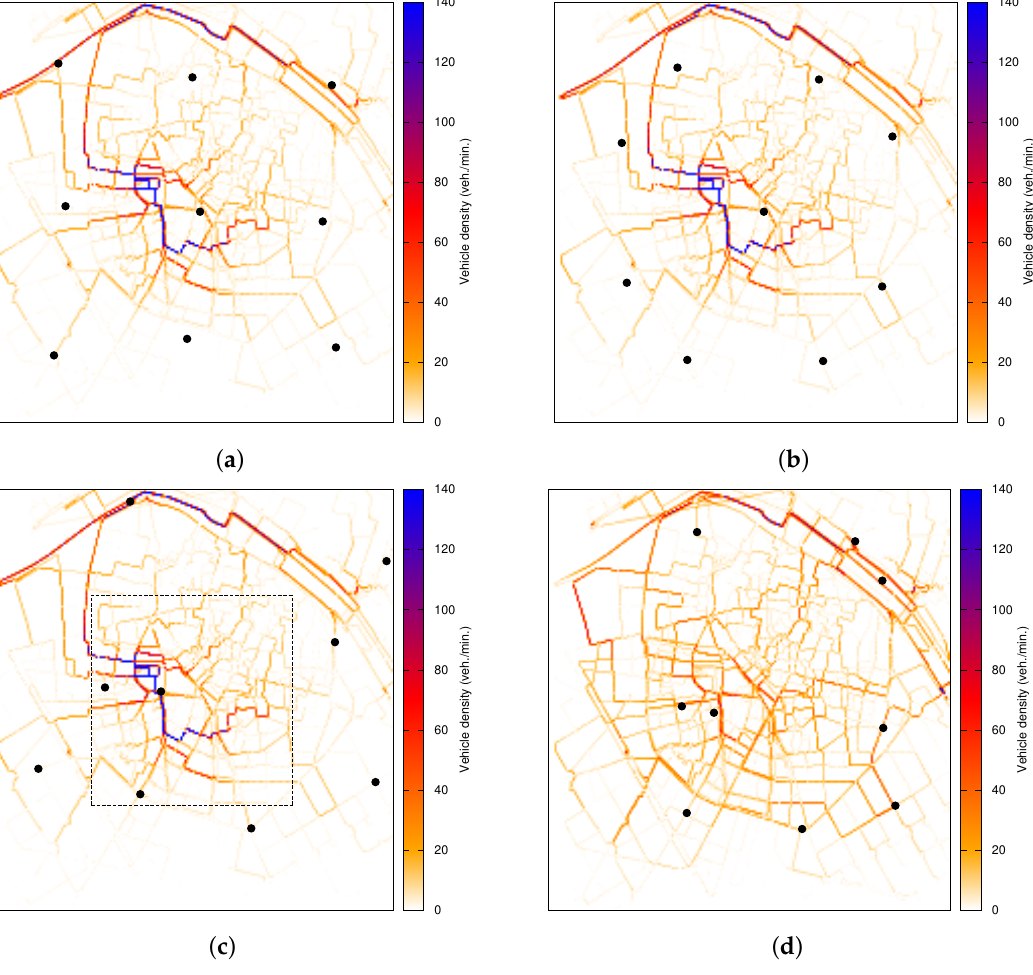
Figure 11. Comparison of the different RSU deployment policies for nine RSUs: Valencia scenario. ( a ) Geographic deployment; ( b ) D-RSU; ( c ) GARSUD with a central downtown; ( d ) GARSUD uniform traffic flow (i.e., without any